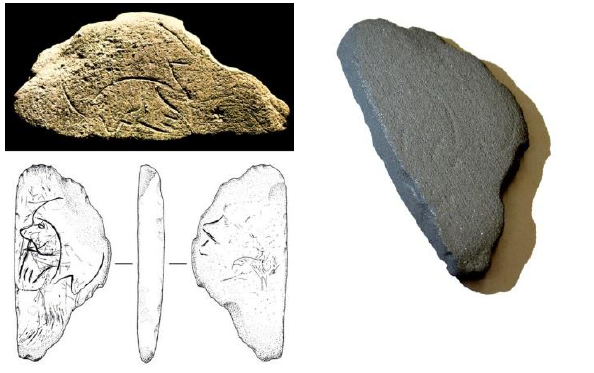
Figure 7. Image and drawings of the limestone slab of the “Uomo barbuto di Vado all’Arancio” and its replica in Alumide.